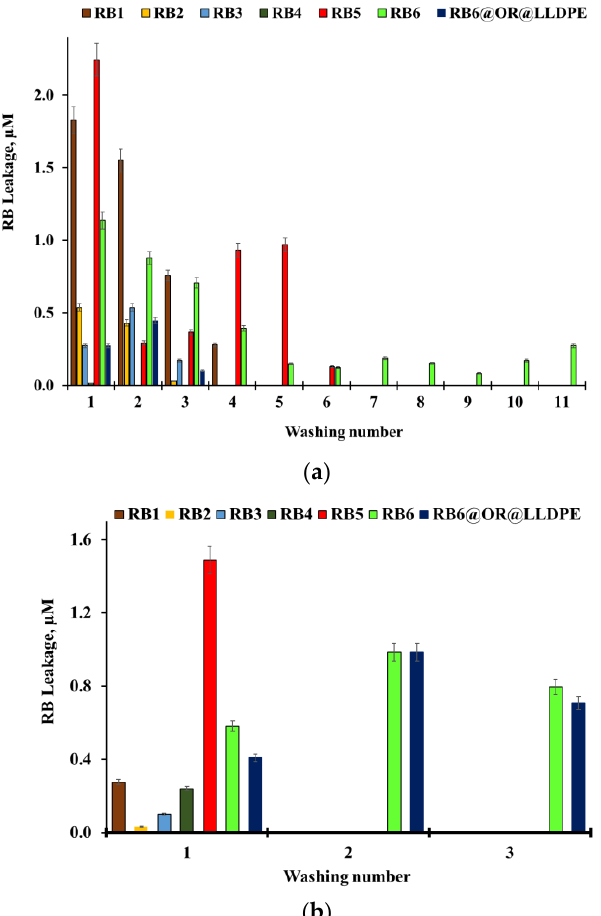
Figure 5. Leaching of RB from RB1, RB2, RB3, RB4, RB5, RB6 and RB6@OR@LLDPE into bacterial suspen- sions of E. coli in saline under illumination with a white luminescent lamp (fluence rate 39.5 mW cm − 2 ) ( a ) and in the dark ( b ) after a number of